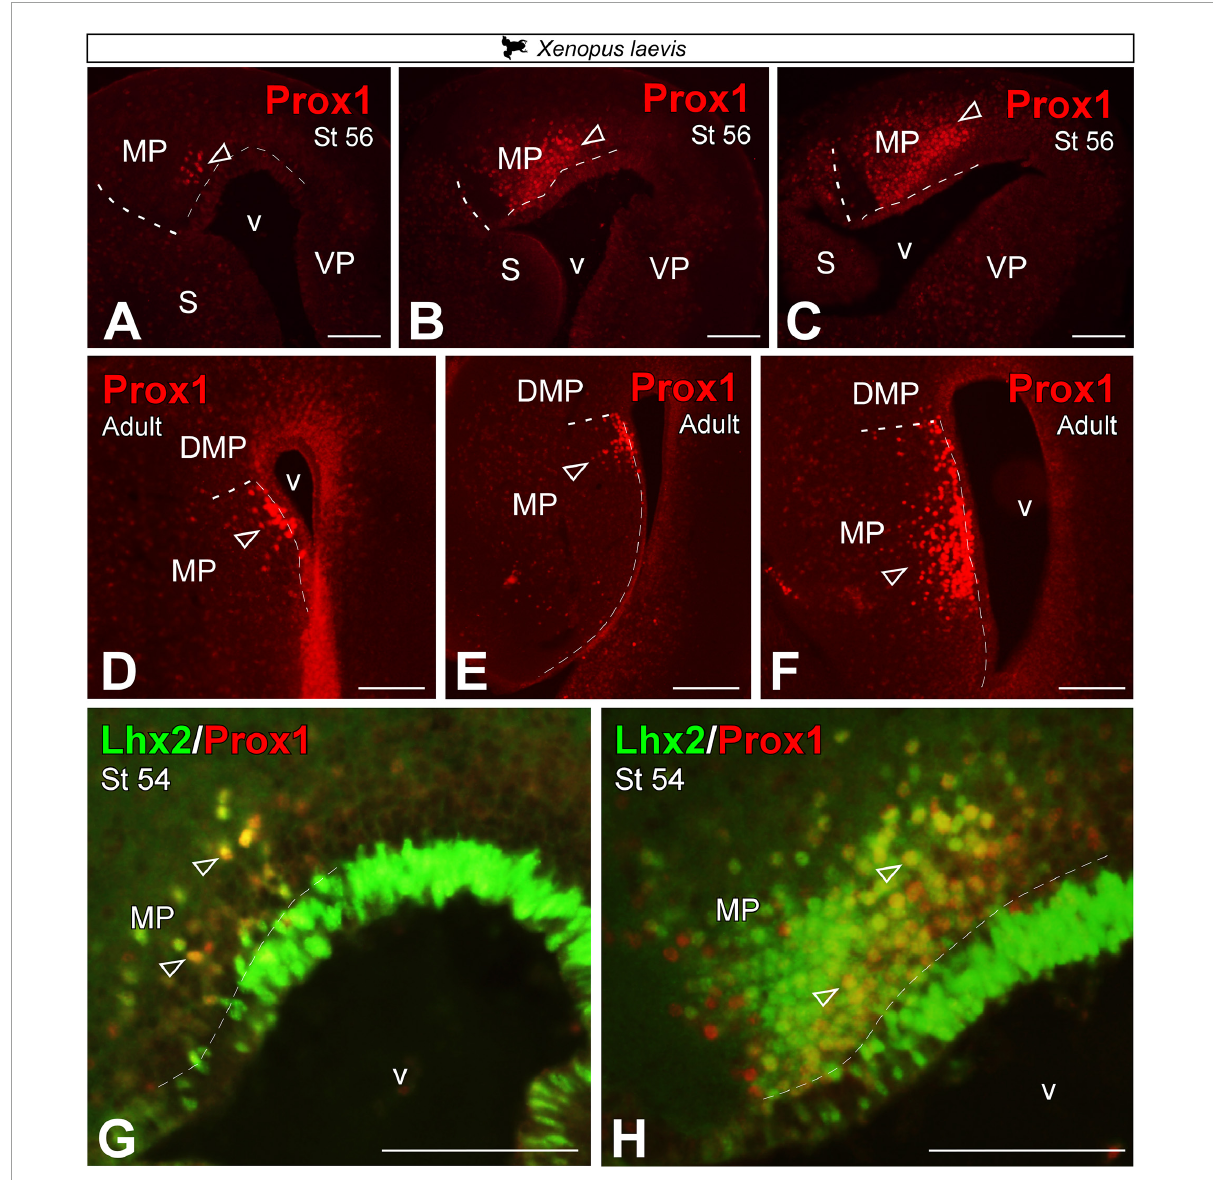
FIGURE6 Photomicrographs of transverse sections through the telencephalon of Xenopus laevis at larval stages (A–C) and adult (D–F) showing, from rostral to caudal levels, Prox1 expression (A–F) and its combination with Lhx2 (G,H) . In each panel, the developmental stage and the color code for the used markers are indicated. Empty arrowheads point to mantle-expressing cells. Scale bar = 200 µ m. See the abbreviation